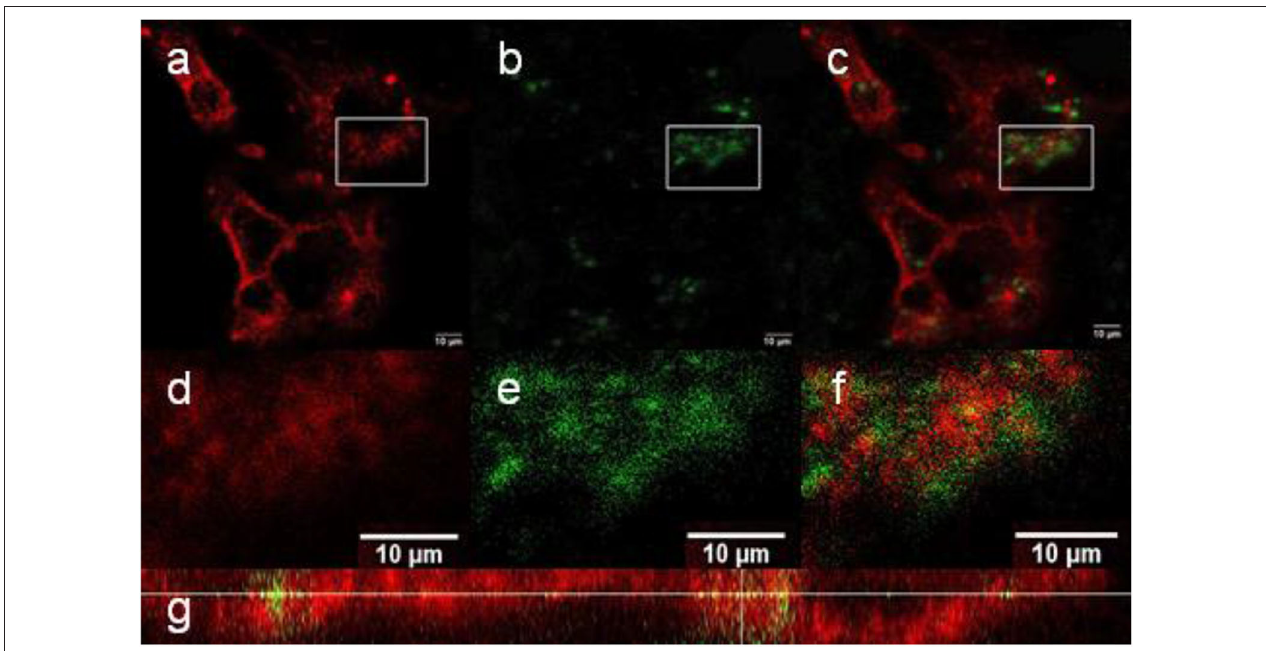
FIGURE 8 | (a–f) Confocal micrographs showing the distribution of NaYF 4 :Yb 3 + /Er 3 + @NaYF 4 :Nd 3 + -PEG 5,475 -RGDS nanoparticles in Hep-G2 cells at 980nm excitation with a laser power of 30–50 mW. (d–f) Detailed micrographs of (a–c) . (a,d) CellMask TM deep red cell-stained cell membrane, (b,e) nanoparticles, and (c,f) overlay of (a,b,d,e) . (g) The xz-plane of NaYF 4 :Yb 3 + /Er 3 + @NaYF 4 :Nd 3 + -PEG 5,475 -RGDS nanoparticle-labeled Hep-G2 cells.